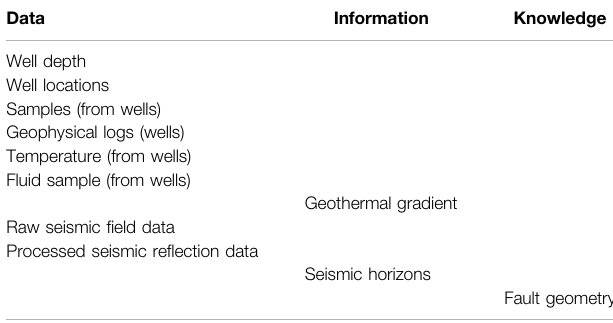
TABLE 1 | Typical data types and their classi fi cation based on the Ackoff. (1989) hierarchical